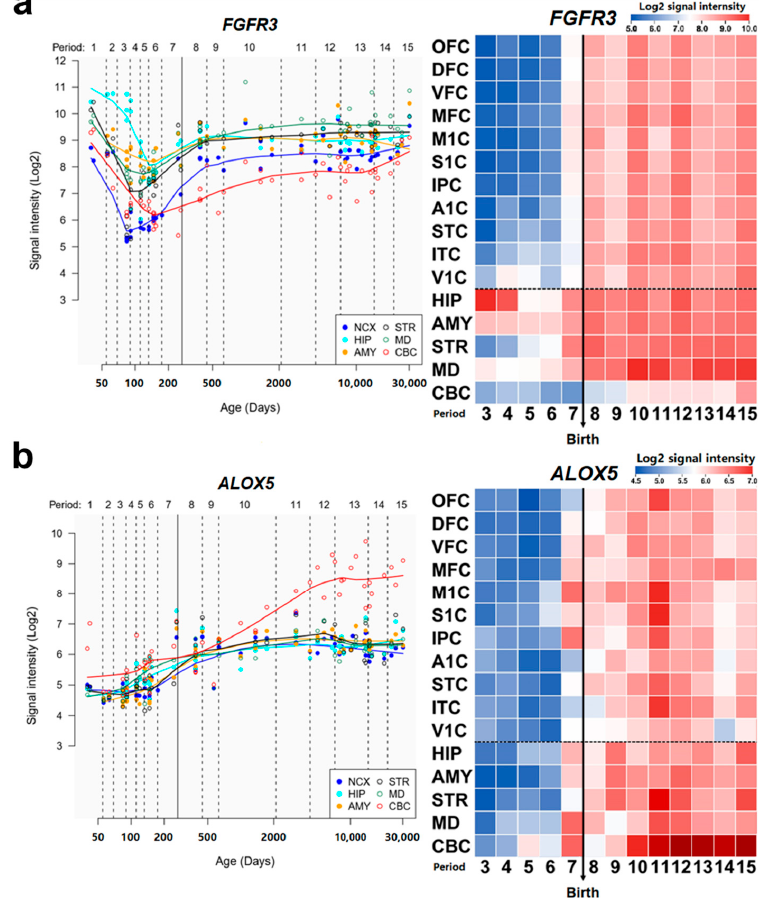
Figure 5. Spatio-temporal expression patterns of ALOX5 and FGFR3 . ( a , b ), left: spatio-temporal expression pattern of ALOX5 ( a ) and FGFR3 ( b ) across age. right: heat map matrix representations of spatio-temporal expression of ALOX5 and FGFR3 . The heatmap display log2-transformed signal intensity across analyzed regions and periods using a heat map color scale from low (blue) to high (red). The dashed horizontal dotted line separates NCX areas from other brain regions. The birth time is marked by a vertical solid line. Abbreviation: NCX, Neocortex; OFC, Orbital prefrontal cortex; DFC, Dorsolateral prefrontal cortex; VFC, Ventrolateral prefrontal cortex; MFC, Medial prefrontal cortex; M1C, Primary motor cortex; S1C, Primary somatosensory cortex; IPC, Posterior inferior parietal cortex; A1C,Primary auditory cortex; STC, Posterior superior temporal cortex; ITC, Inferior temporal cortex; VIC, Primary visual cortex; HIP, Hippocampus; AMY, Amygdala; STR, Striatum; MD, Mediodorsal nucleus of the thalamus; CBC, Cerebellar cortex.